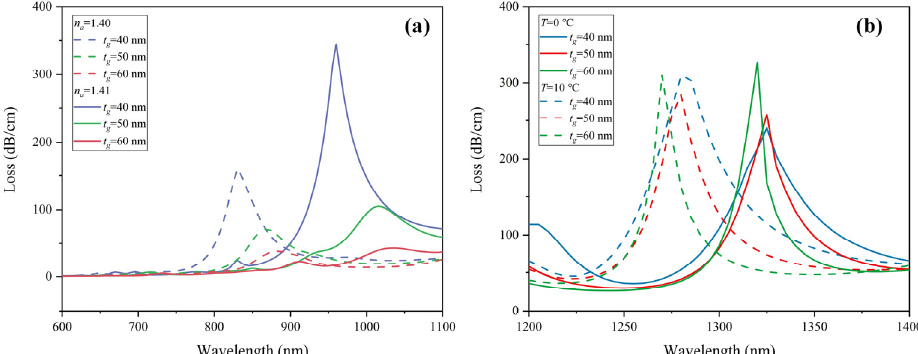
Figure 8. Loss spectra of ( a ) y- polarization core mode in RI sensing channel when analyte RI varies from 1.40 to 1.41, and ( b ) x- polarization core mode in temperature sensing channel under ambient temperature from 0 to 10 °C with different thicknesses of the Au film t g .